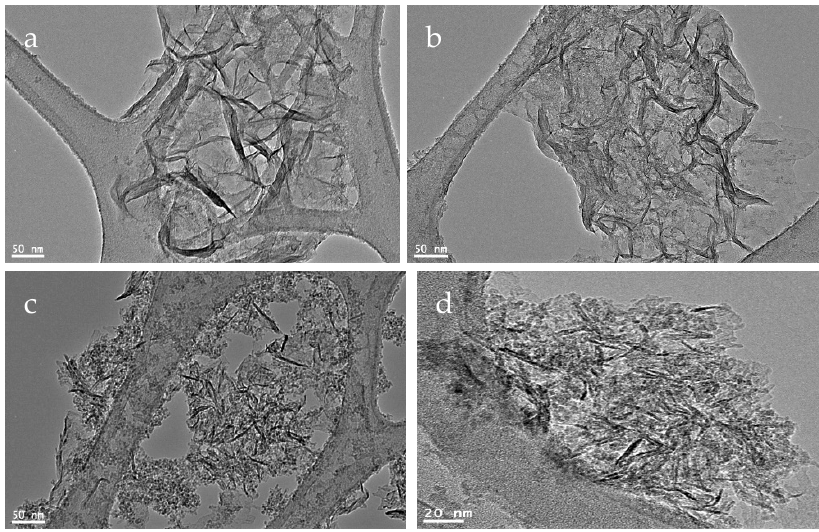
Figure 3. TEM images of the nanocomposite NC-1: ( a , b ) before thermal treatment and ( c , d ) after thermal treatment.